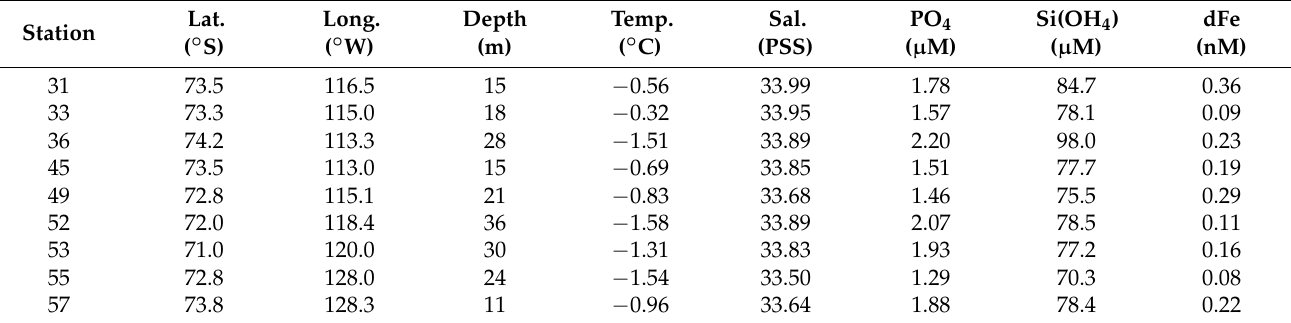
Figure 1. Location of the Amundsen Sea in the Southern Ocean ( A ) and a closeup of stations sampled within the Amundsen Sea ( B ). GIS = West Getz ice shelf region, DIS = Dotson ice shelf region. The black line shows the rough outline of the Amundsen Sea Polynya (ASP) during the period of sampling. Stations within the ASP are in black and stations outside the ASP are in white. Based on ice cover, density, and autofluorescence depth profiles, intermediate station 49 was treated as a non-ASP station (see Section 2). Table 1. Station location with physical (temperature, Temp.; and salinity, Sal.) and chemical (dissolved inorganic phosphate, PO4; silicate, Si(OH) 4 ; and dissolved iron) characteristics at the sampling depth. Latitude and longitude are given in decimal degrees. Stations 36–45 were defined as ASP stations and stations 49–57 as non-ASP